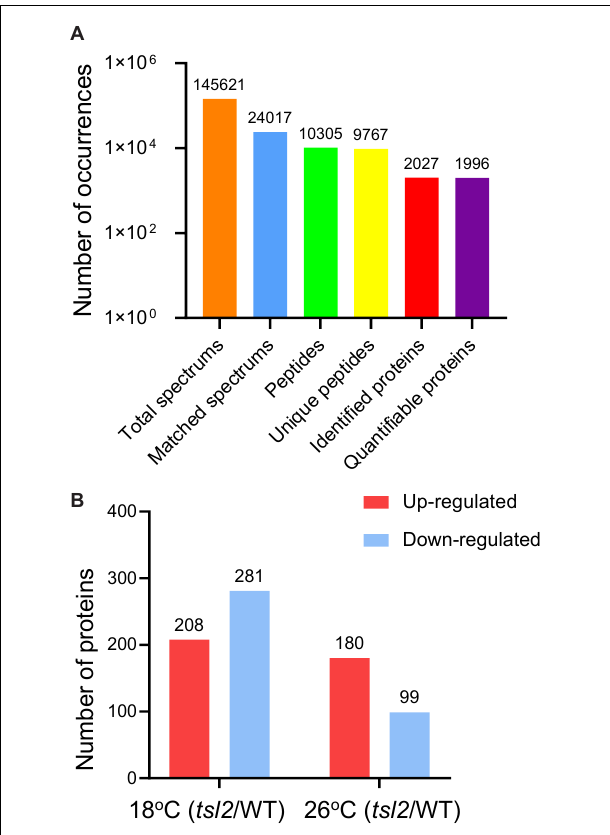
FIGURE 5 | Quantitative proteomic study of the effect of TSL2 mutation on chloroplast proteome. (A,B) Basic information on the proteomic analysis. The wild-type (WT) and tsl2 mutant plants grown under normal growth temperature (22 ◦ C) for 4 days were transferred to 18 ◦ C or 26 ◦ C for 12 days and harvested for chloroplast isolation and further proteomic analysis. Basic information on proteomics was shown in (A,B) .